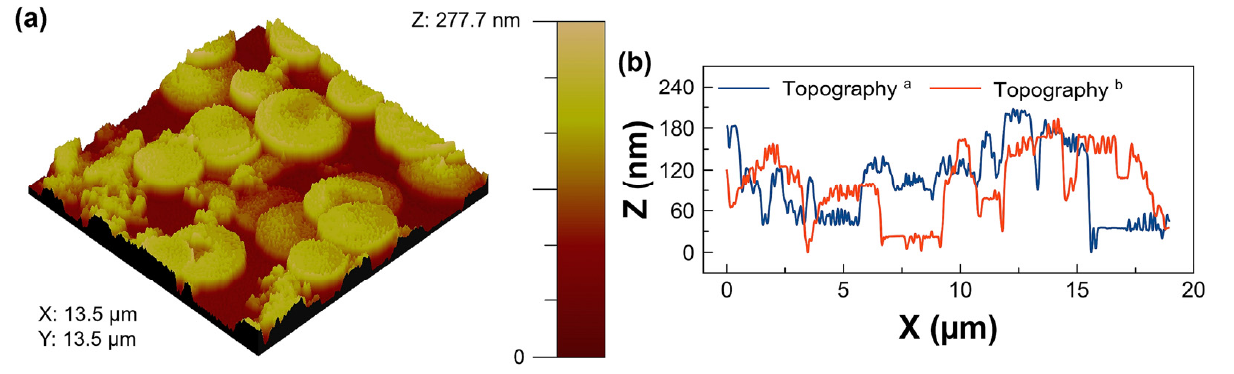
Figure 2. ( a ) XRD pattern, and ( b ) FTIR spectrum of Ag-ZnS microspheres. Figure 3a shows a typical micrograph of sensor coatings containing Ag-ZnS micro- spheres embedded in the MIP receptor layer. The surface profiles of the coating are shown in Figure 3b. The surface of the layer exhibits the presence of micro-sized Ag-ZnS spheres with diameters in the range of 1.5–2.5 µ m. The microspheres are uniformly dispersed on the surface.